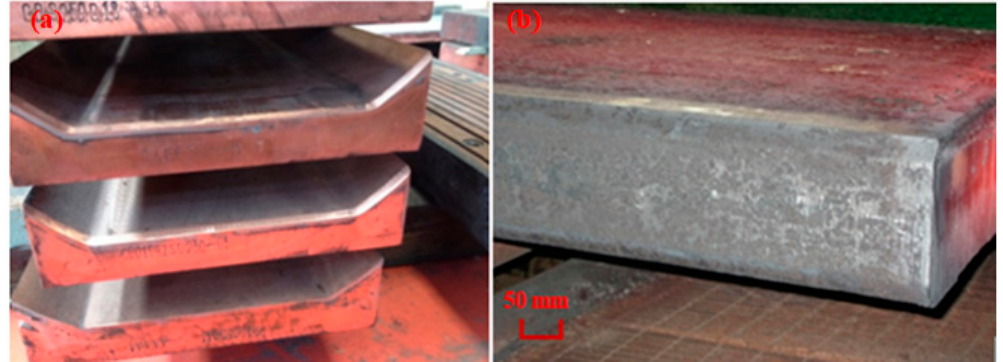
Figure 16. Chamfered mold and chamfered slab. ( a ) Chamfered mold; ( b ) Chamfered slab